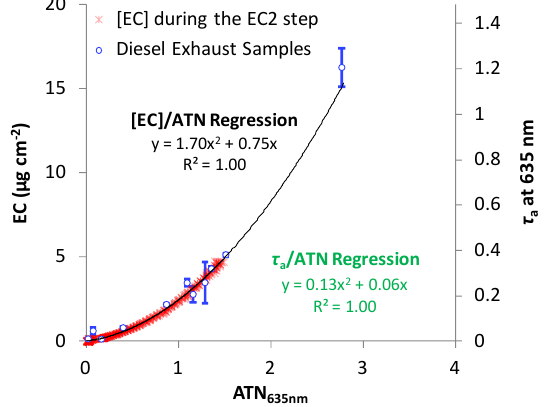
Figure 5. τ a ,λ –ATN λ relationships for 405–980nm wavelengths, based on a diesel exhaust reference sample. Results for 532nm are not shown owing to lack of sufficient detector signal-to-noise ratio at this wavelength.